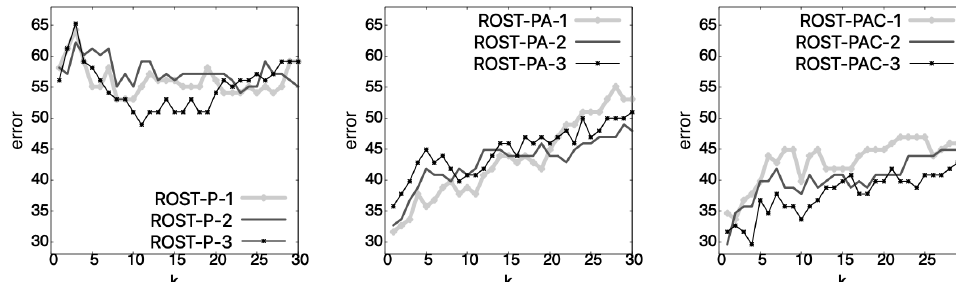
Figure A5. K-NN results on the considered datasets. In total, 30 runs are performed with k varying with the run index. The percentage of incorrectly classified data is plotted.